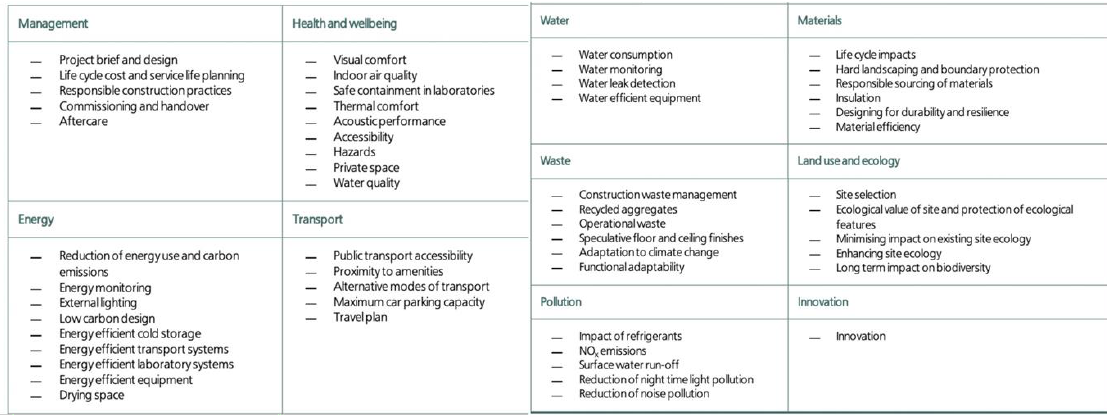
Figure 1: example of sustainability criteria for buildings in GBRS - BREEAM New Construction 2016 (source: